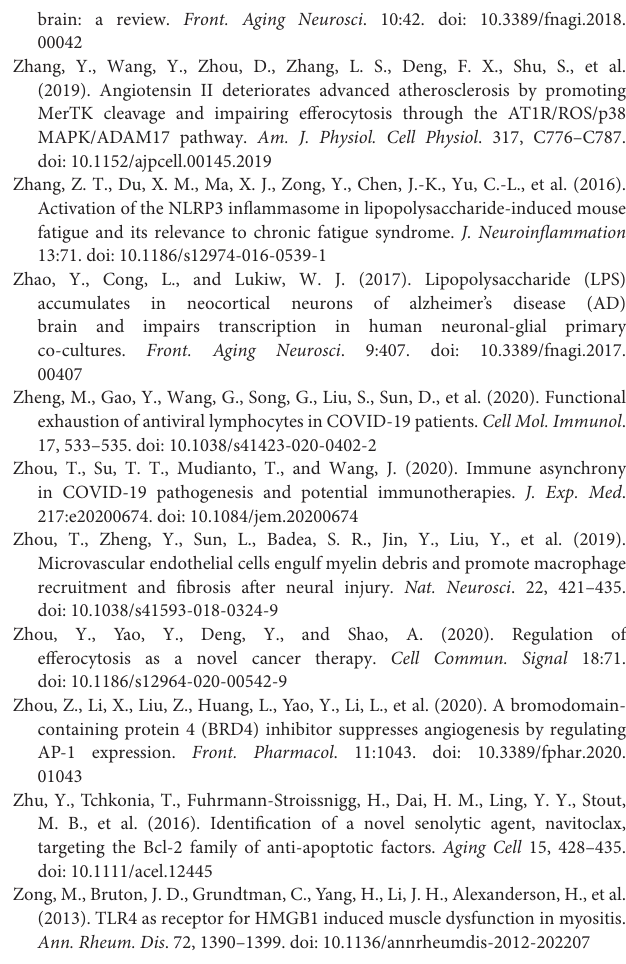
Disclaimer: WhereauthorsareidentifiedaspersonneloftheInternational Agency for Research on Cancer/WHO, the authors alone are responsible for the views expressed in this article and they do not necessarily represent the decisions, policy or views of the International Agency for Research on Cancer/WHO. Conflict of Interest: The authors declare that the research was conducted in the absence of any commercial or financial relationships that could be construed as a potential conflict of